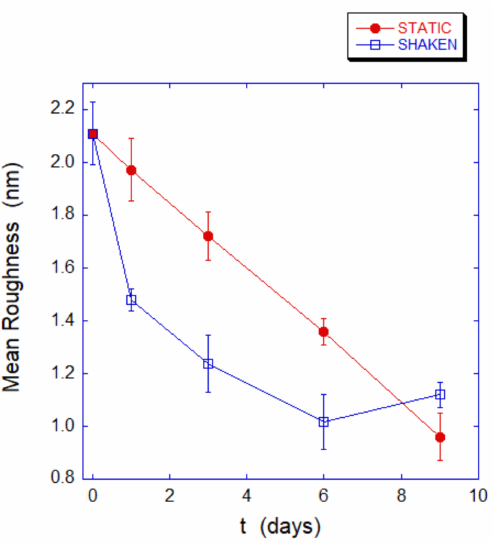
Figure 6. Roughness trend measured for static controls (red circles) and for mechanically stimulated sample (blue squares). The faster decreasing trend in shaken cells indicates a larger disengagement of the cell skeleton from the overlying membrane over time.